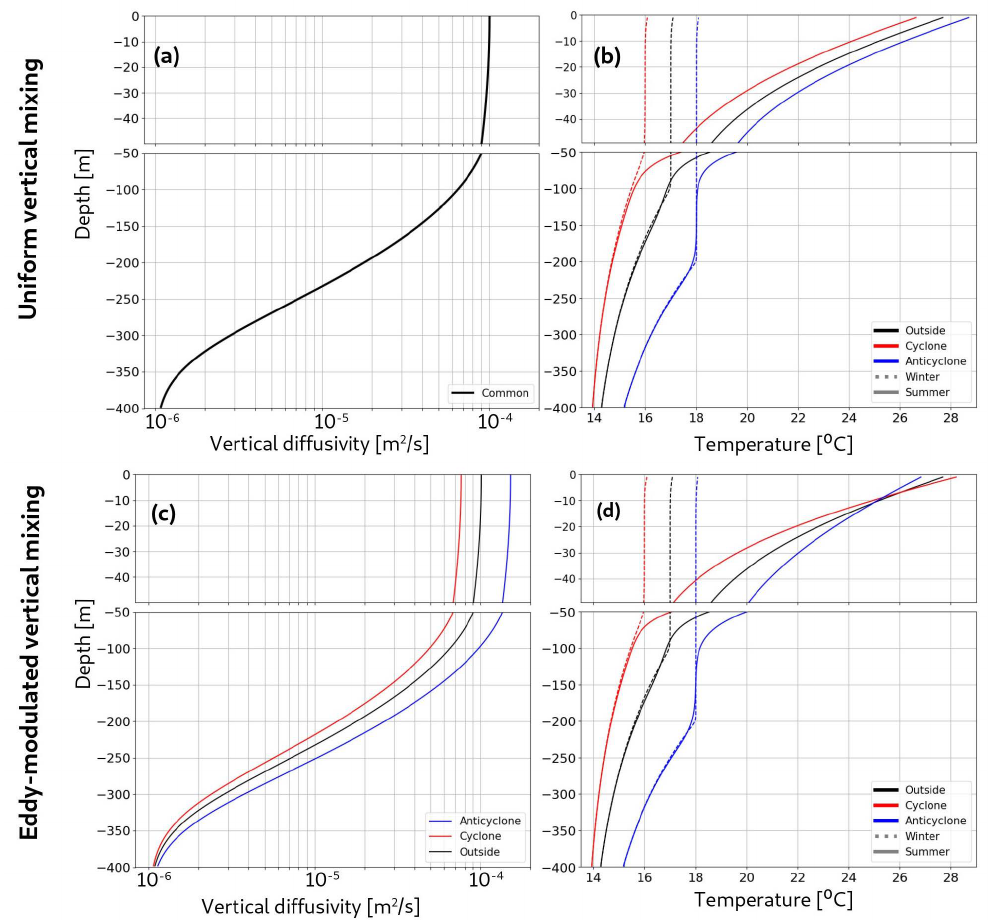
Figure 10. One-dimensional (1D) single column experiments: vertical structure. With a uniform vertical mixing: ( a ) vertical diffusivity A ( z ) from Equation (5) and ( b ) temperature profiles in winter (dashed line) and summer (continuous line), corresponding time of the year being reported on Figure 11b . Initial winter profiles are set in Equation (3). With eddy-modulated vertical mixing: ( c ) vertical diffusivity and ( d ) temperature